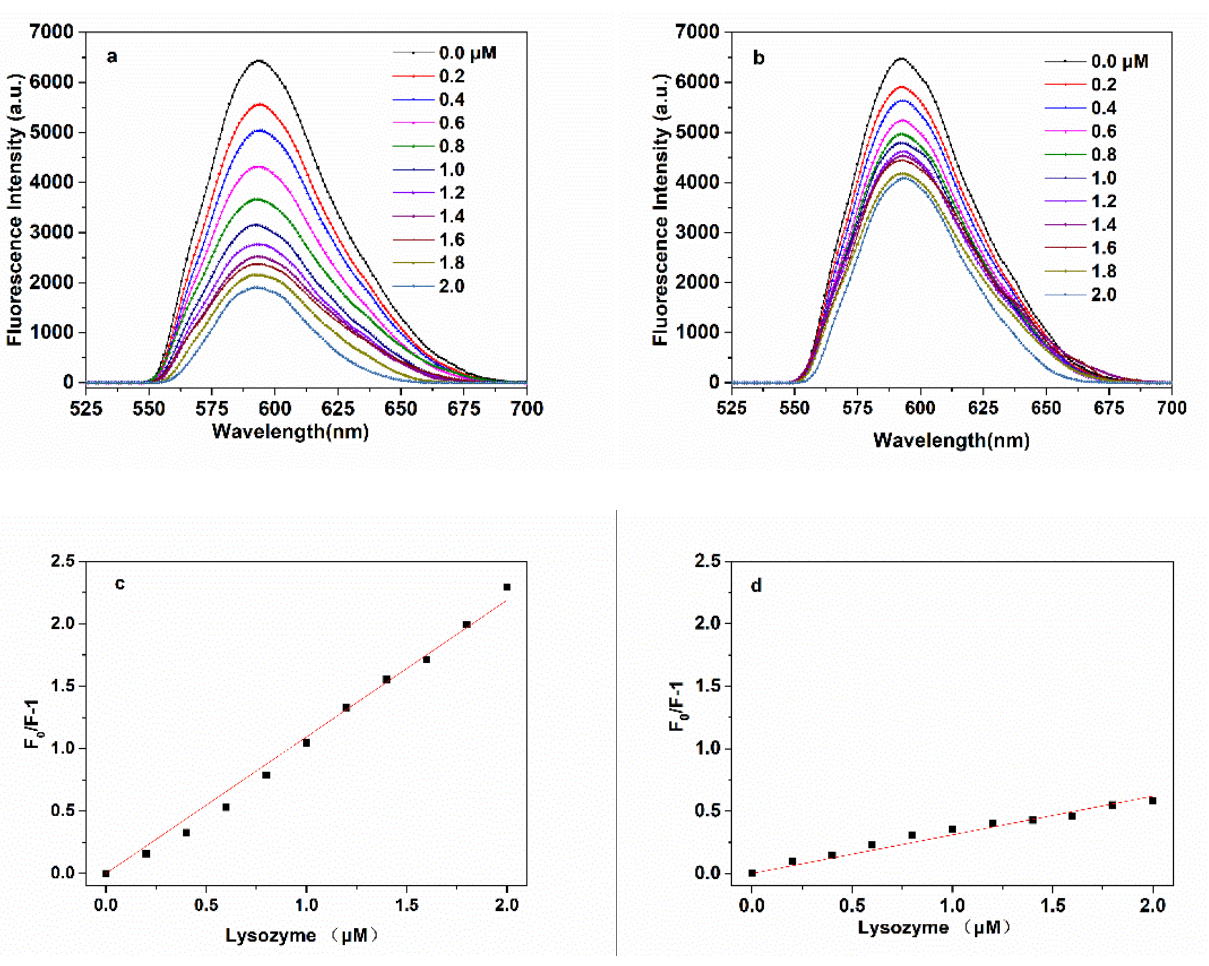
Figure 8. Fluorescence emission spectra of ( a ) MNP/QD@MIPs and ( b ) MNP/QD@NIPs with increasing concentrations of lysozyme; the linear calibration of the fluorescence quenching efficiency (F 0 /F − 1) versus lysozyme concentration of ( c ) MNP/QD@MIPs and ( d ) MNP/QD@NIPs.